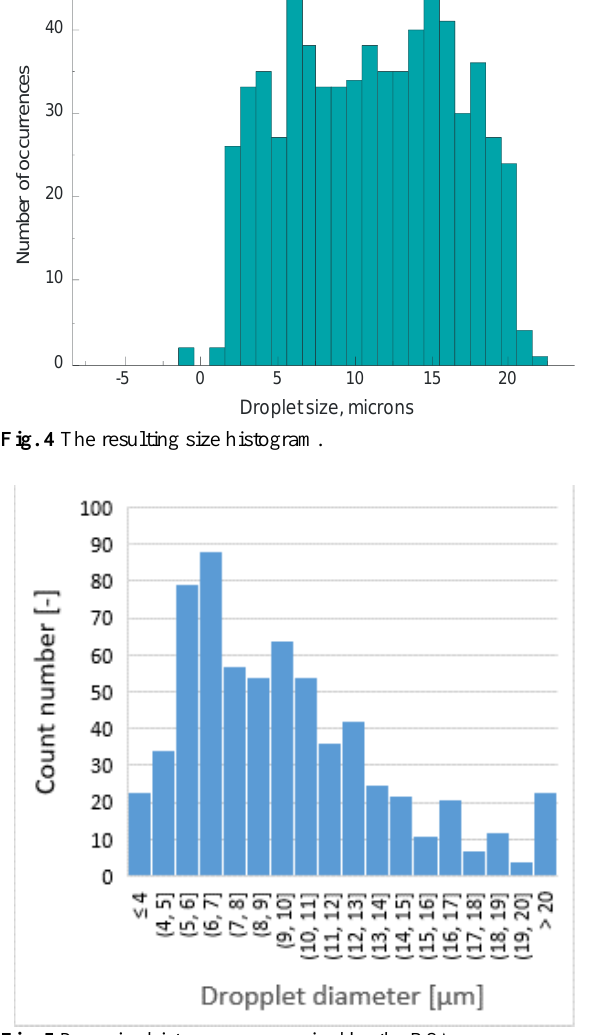
Fig. 5 Dropsize histogram as acquired by the BSA